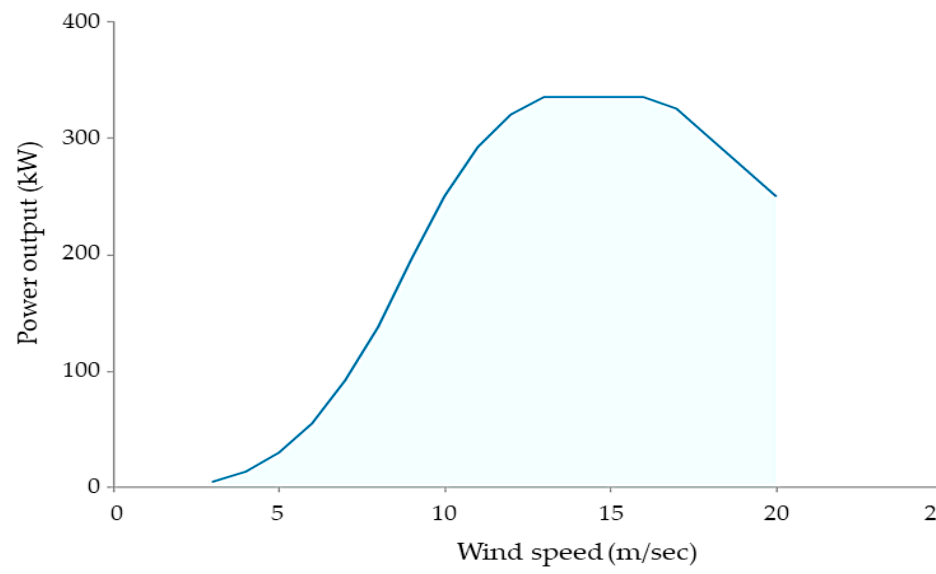
Figure 5. Power curve of the wind turbine vs. wind speed.